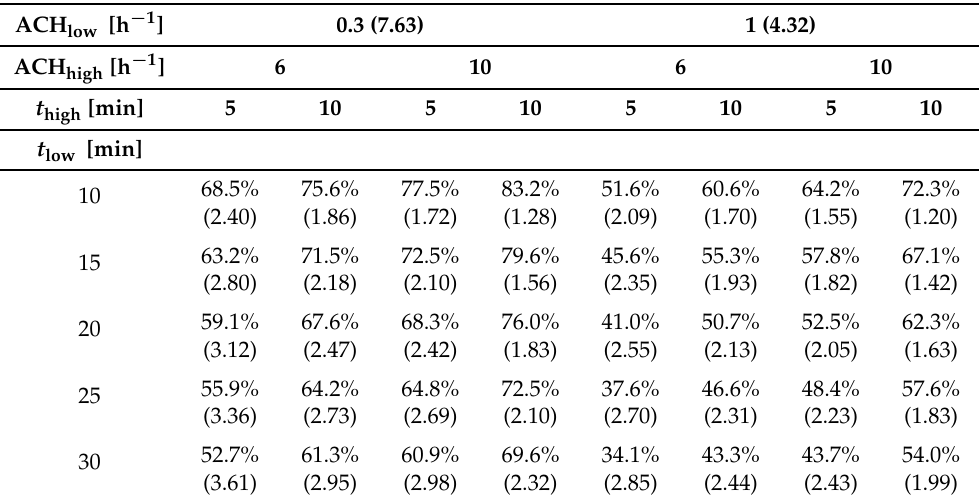
Table 6. Reduction of the basic reproduction number with periodical ventilation regimes. ACH low and ACH high are the basal and the high ventilation rates. t low and t high are the duration of each ventilation stage (alternating times with ACH low and ACH high , respectively). The percentages of reduction are referred to the basal situation, with a constant ACH low ventilation rate. The basic reproduction number for the basal situation is indicated between parenthesis next to the basal ventilation rate value. The basic reproduction number for each situation is detailed below each percentage